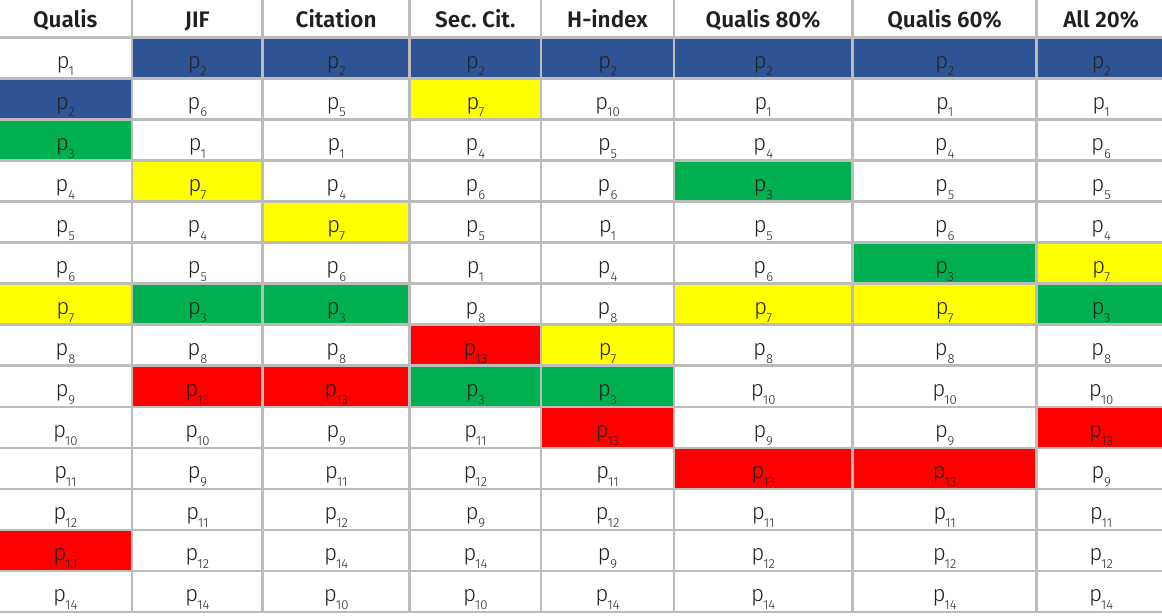
Table V. Productivity ratings for the study sample, according to the 8 established criteria. Qualis